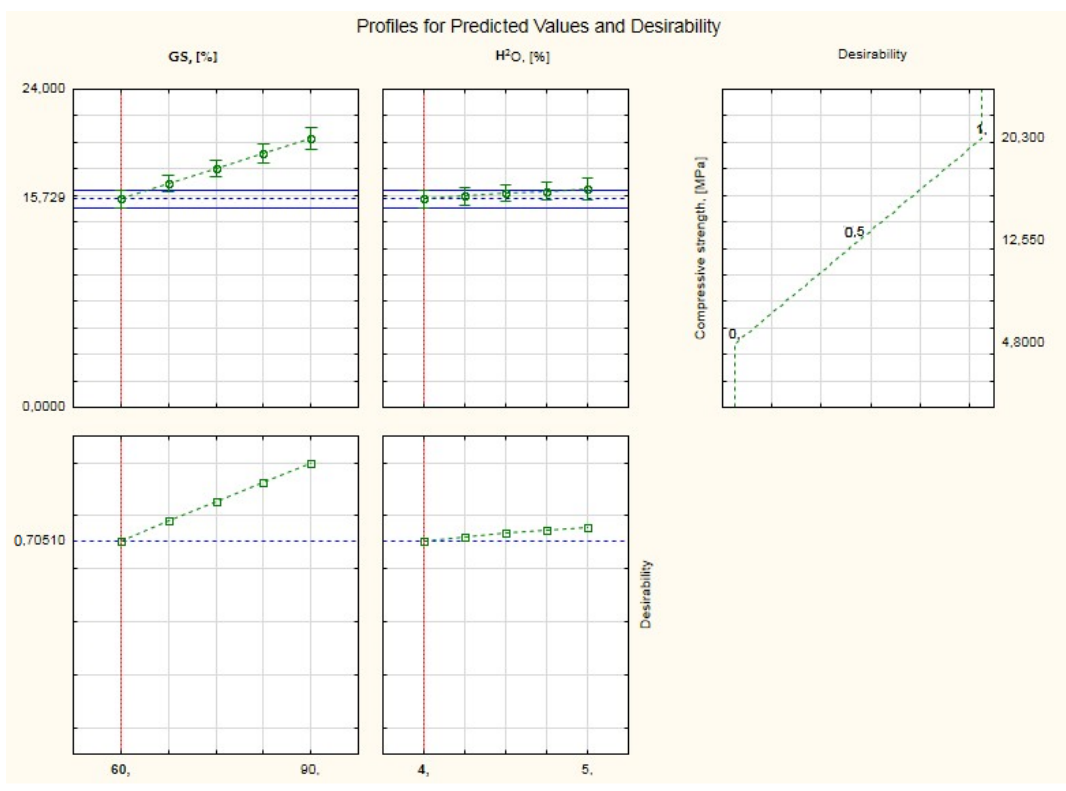
Figure 10. Total usability profile of silicate products modified with recycled glass sand